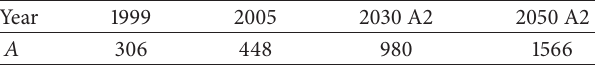
Table 5: The values of the maximum flood damage 𝐴 (100 million).